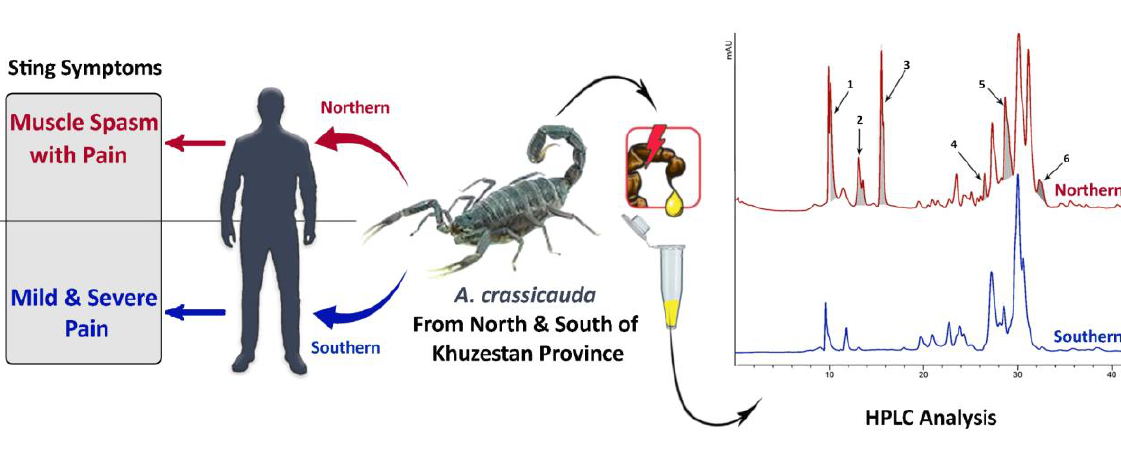
Figure 1: Graphical abstract